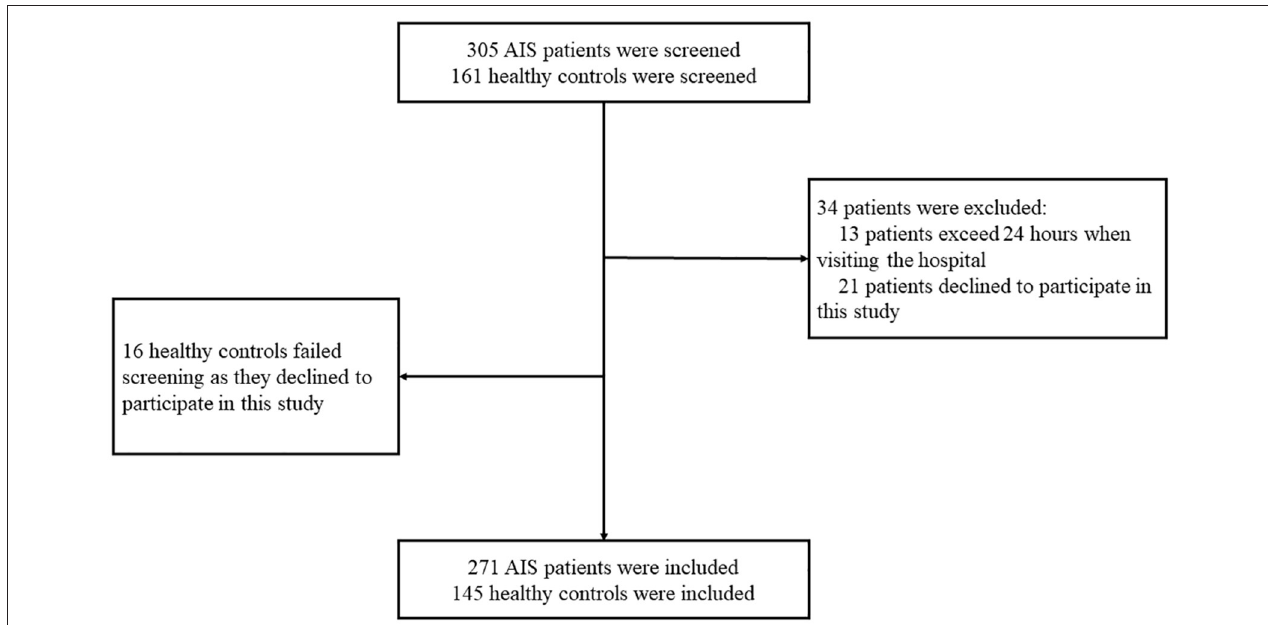
FIGURE 1 | Participants screening flowchart. In this study, 305 patients with acute ischemic stroke (AIS) and 161 non-stroke controls were screened for eligibility for participation. A total of 34 patients with AIS failed screening for the following reasons: (1) 13 patients visited the hospital beyond 24h since symptom onset; (2) 21 patients declined to participate. Finally, 16 non-stroke controls failed the screening since they declined to